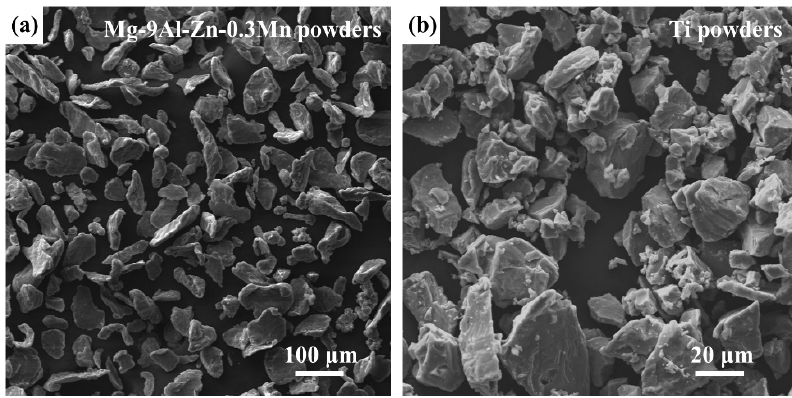
Figure 1. SE images of ( a ) Mg-9Al-Zn-0.3Mn powders and ( b ) Ti powders.